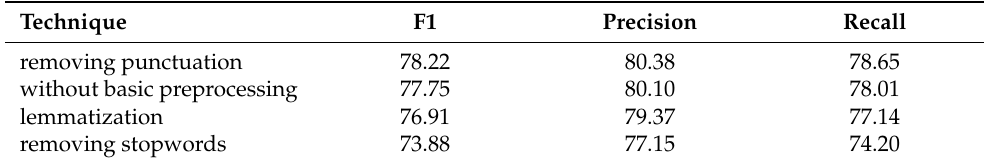
Table 4. Results obtained for our top-performing approach based on cased version of BETO pretrained model when enriched with 50 new tokens and applying a specific text preprocessing technique (five- fold CV results). We used weighted version for all metrics to account for label imbalance (this can result in an F-score that is not between precision and